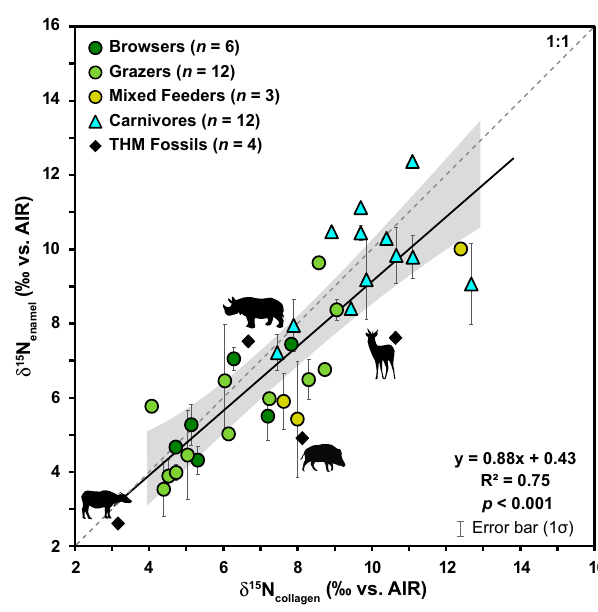
Fig. 2 Regression of paired δ 15 N enamel versus δ 15 N bone-collagen values -- x ± 1 σ ) for all modern African mammals ( n = 33). The dashed line ( represents a hypothetical 1:1 relationship between bone collagen and enamel values. The solid line indicates the regression, with a bootstrapped 95% con fi dence interval illustrated with gray shading. The equation for the regression, R 2 value, and p value are indicated in the lower right of the fi gure. δ 15 N δ 15 N enamel versus dentin-collagen values for the four fossil Tam Hay Marklot (THM) specimens (see Table 2) are also plotted for reference (black diamonds) but were not included in the regression